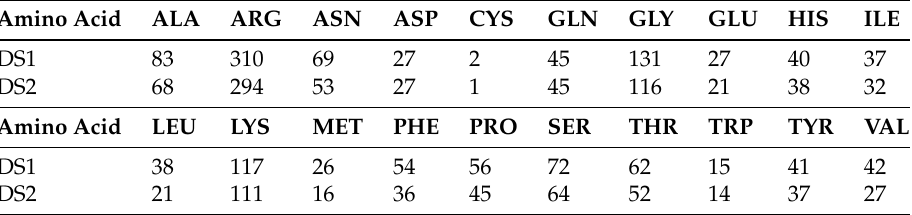
Figure 9. Illustration of the minor groove width categories: ( a ) Narrow minor groove (T4 Endonuclease VII H43N mutant in complex with heteroduplex DNA, PDB ID 2QNF); ( b ) standard minor groove (human Pax-6 paired domain–DNA complex, PDB ID 6PAX); ( c ) wide minor groove, (topoisomerase II alpha bound to DNA, PDB ID 4FM9). In this case, the wide minor groove is associated with bending of the DNA structure. The minor groove nitrogen and oxygen atoms are colored blue and red, respectively. Table 3. The numbers of residues for all amino acid types in the DS1 and DS2